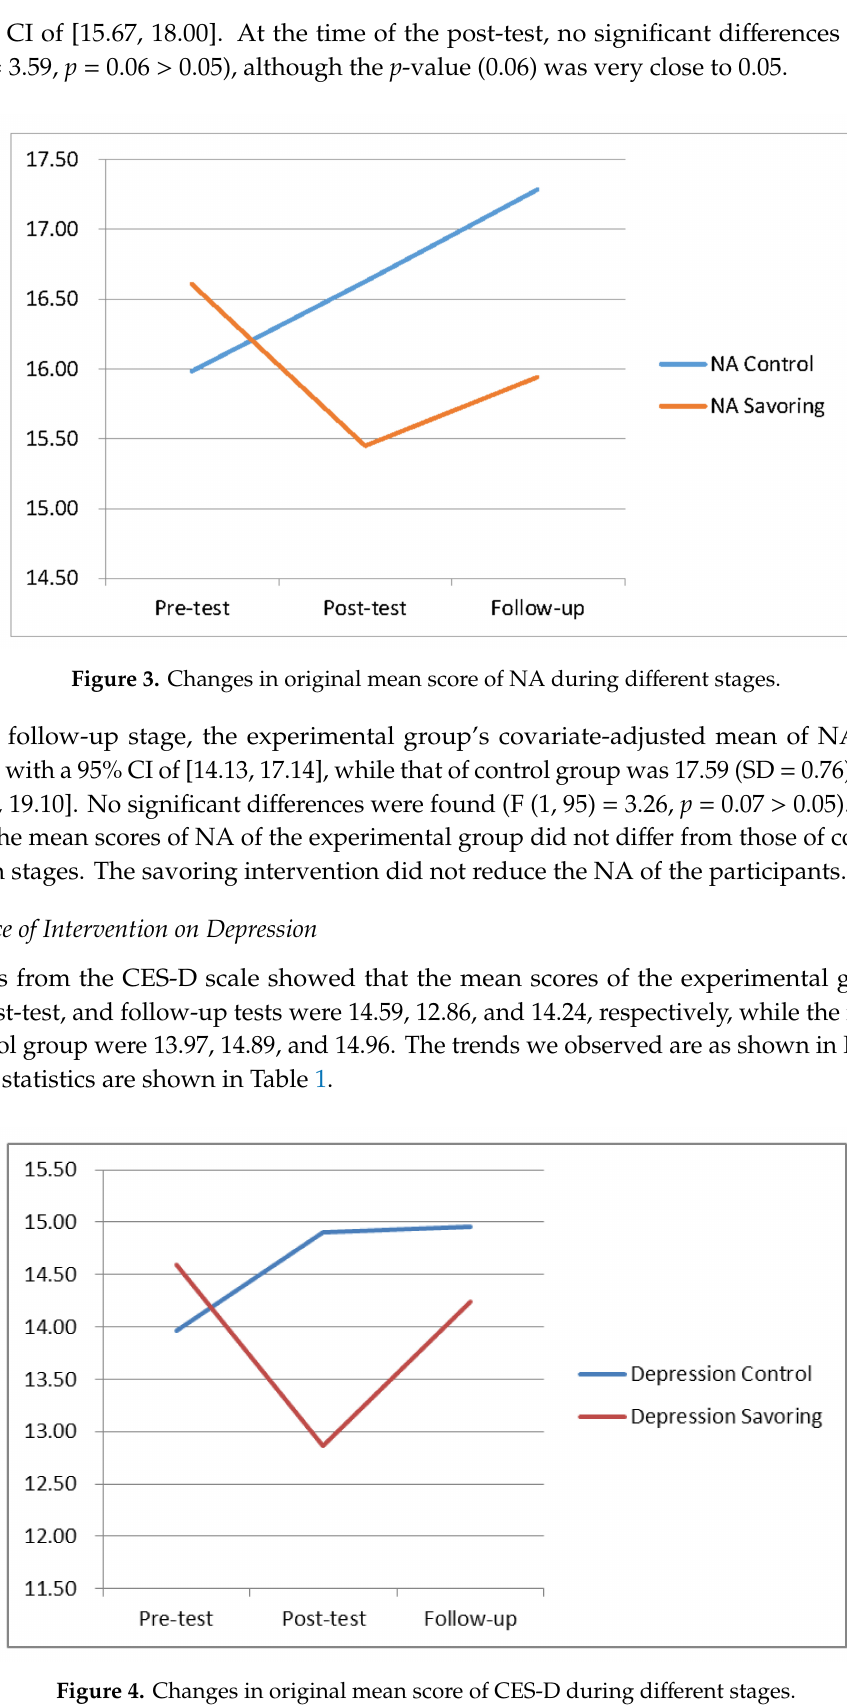
Figure 4. Changes in original mean score of CES-D during di ff erent